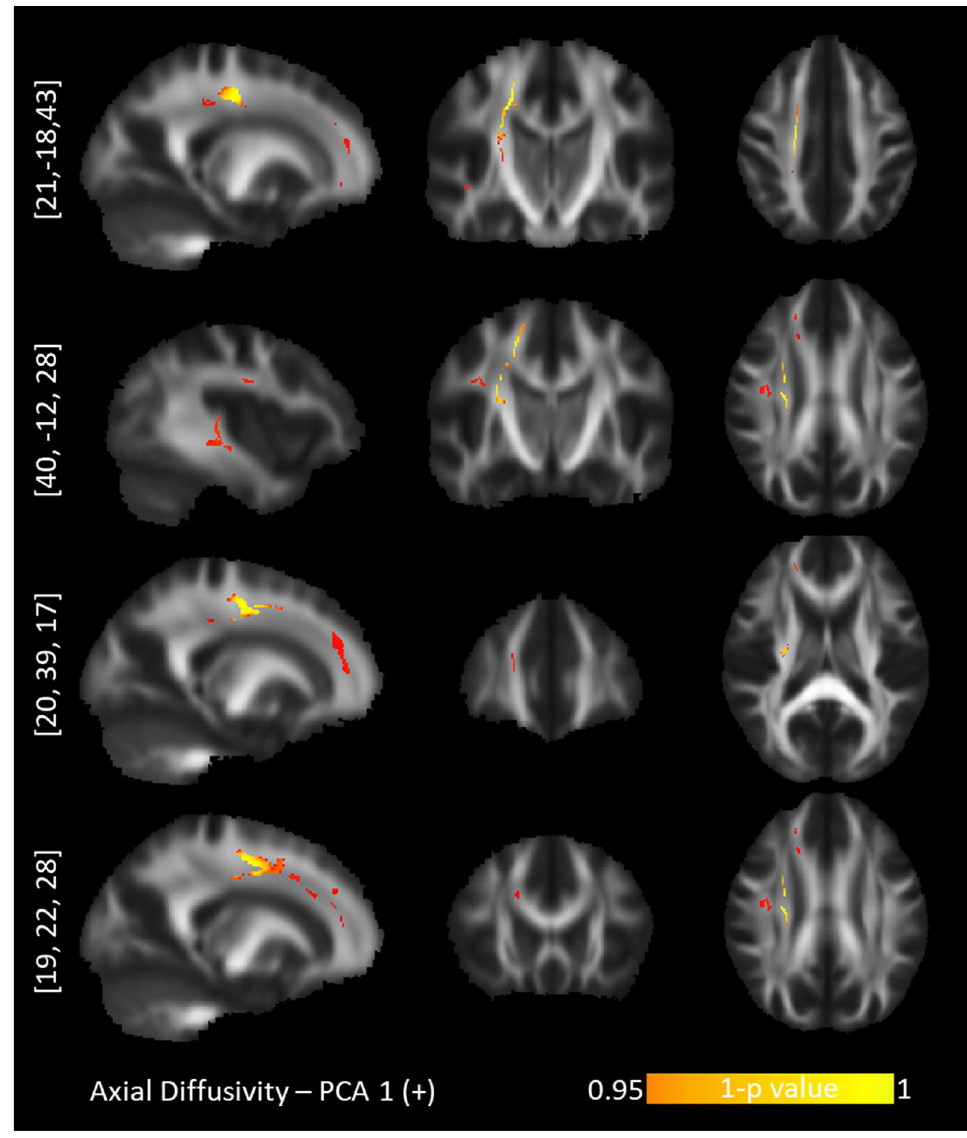
Figure 2. TBSS positive correlations between axial diffusivity and the "Optimism" personality profile. Upper row: corticospinal tract. Second row: dorsal superior longitudinal fasciculus. Third row: anterior corpus callosum. Bottom row: anterior cingulum